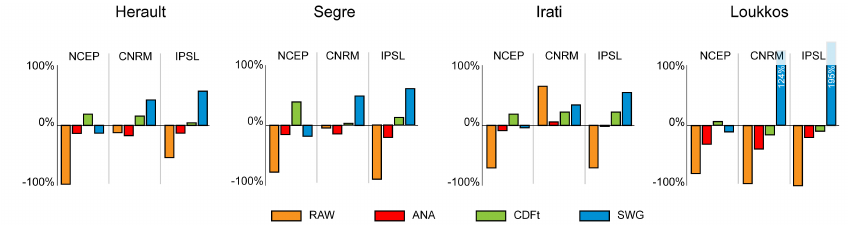
Figure 6. Comparison of the downscaling methods according to the cumulative volume error (VE C ) used as a criterion to compare the downscaling methods applied to NCEP, CNRM and IPSL climate inputs in the four basins. The smaller the absolute value of the criterion, the better the